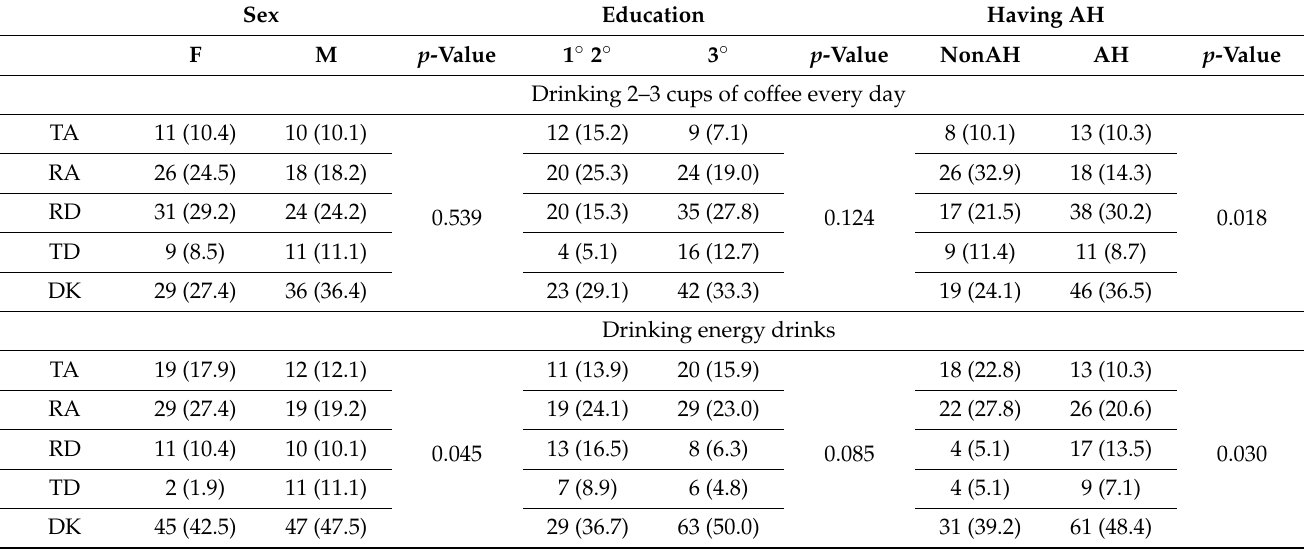
Table 9. Drinking coffee and energy drinks as a factor that increases the incidence of hypertension by gender, education, and having hypertension (N =